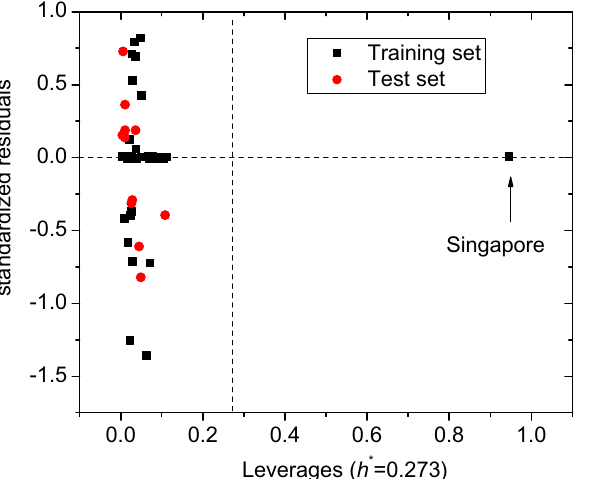
Figure 3. The standardized residuals vs the leverage values (generated by the OriginPro 8.5.0 SR1 software— http:// www. Origi nLab.